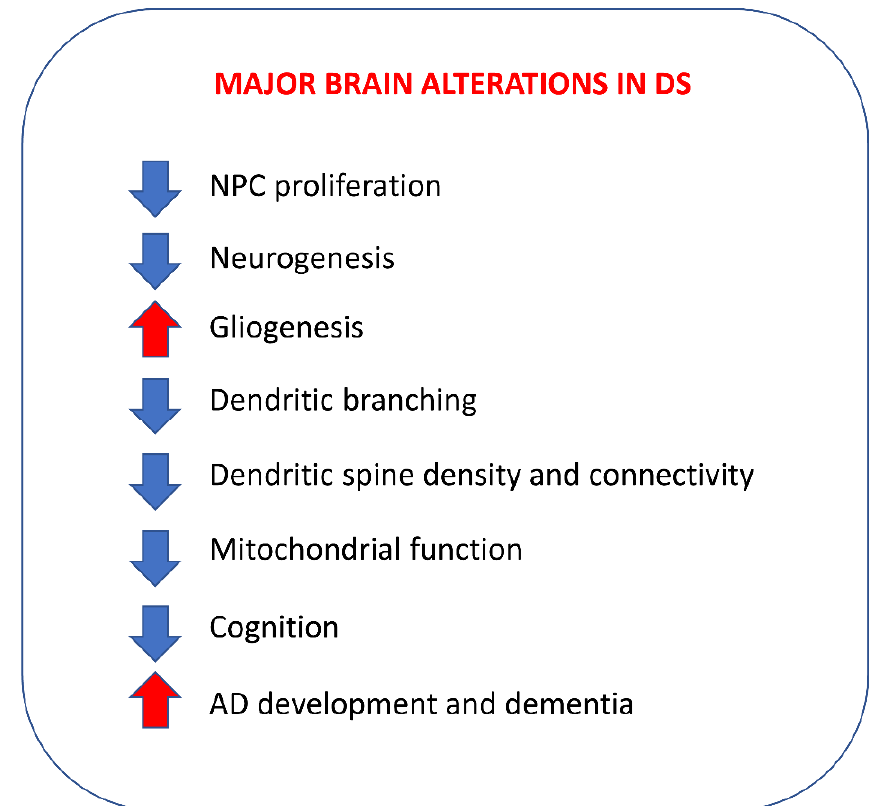
Figure 1. Summary of the major neurodevelopmental alterations in Down syndrome. See text for explanation and references. Abbreviations: AD, Alzheimer’s disease; NPC, neural progenitor cells. The upward pointing red arrows indicates an increase. The downward pointing blue arrows indicates a reduction.